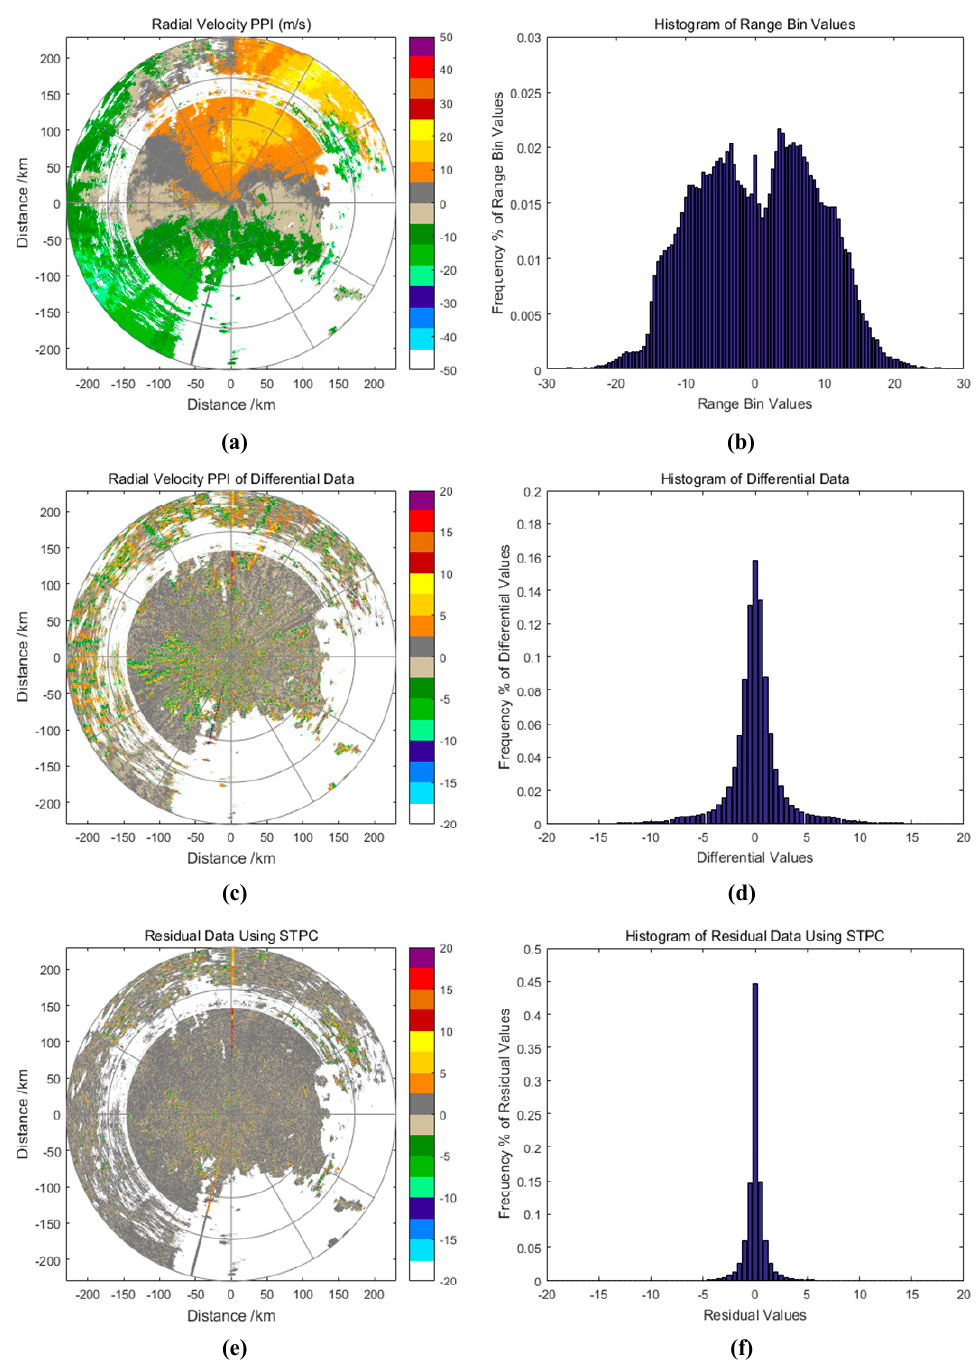
Figure 8. The distribution of radial velocity data, radial velocity differential data and radial velocity residual data using STPC: ( a ) Radial velocity PPI of CINRAD SA data; ( b ) frequency histogram of radial velocity data; ( c ) radial velocity PPI of differential data; ( d ) frequency histogram of radial velocity differential data; ( e ) radial velocity PPI of residual data using STPC; and, ( f ) frequency histogram of radial velocity residual data using STPC.